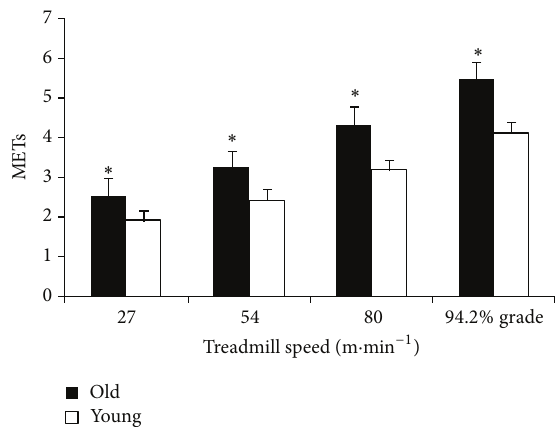
Figure1:TreadmillspeedandcorrespondingmeasuredMETvalues among young and elderly participants. ∗ Significantly greater than the younger group, 𝑃 < 0.05